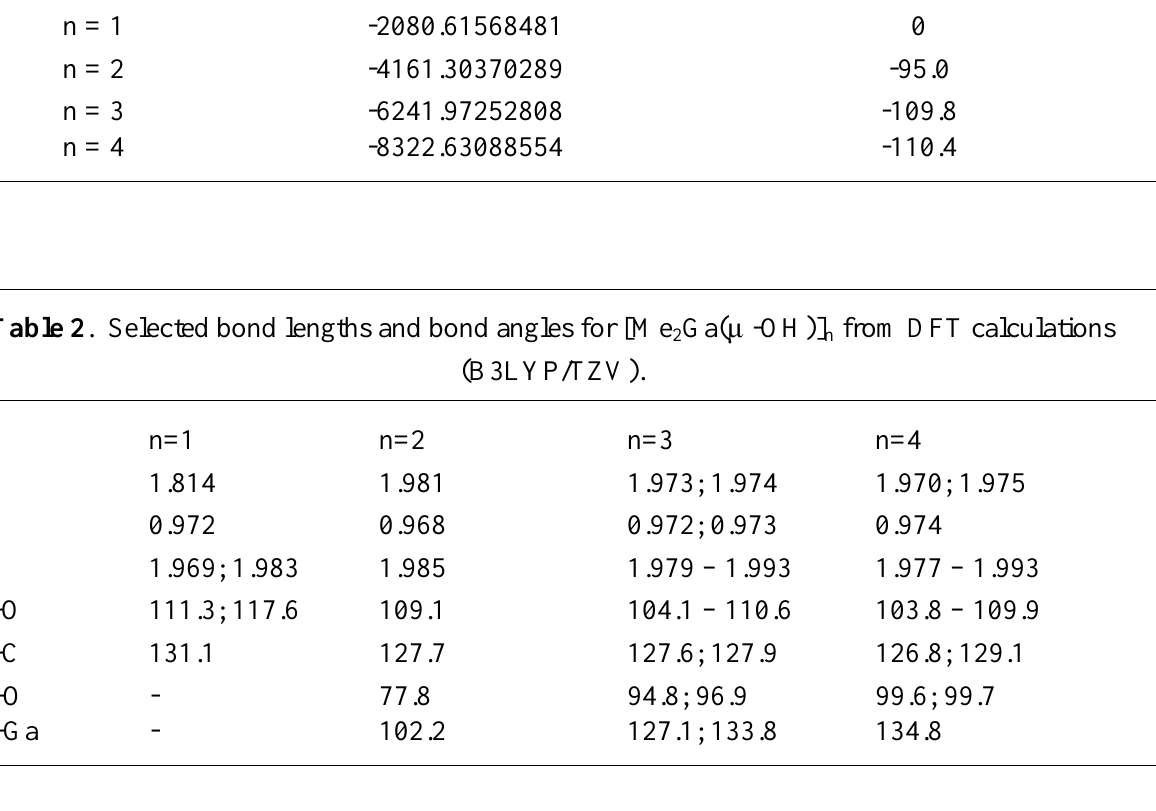
Table 1. Total self-consistent field (SCF) and relative energies for oligomers of dimethylgallium hydroxide predicted by DFT calculations (B3LYP/TZV).